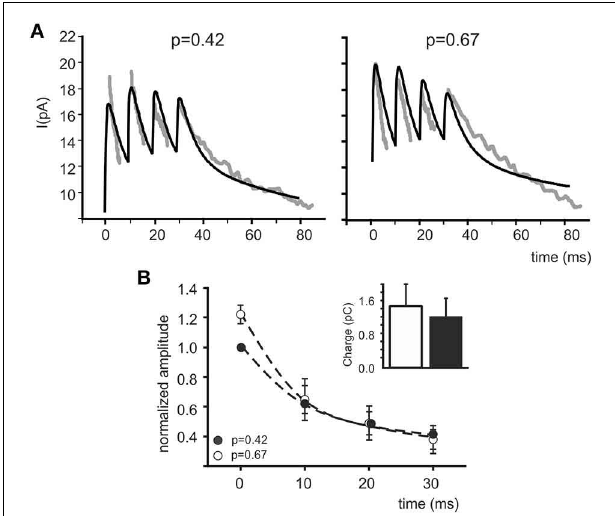
FIGURE 3 | Fitting eIPSC trains with the model. (A) Fittings of experimental traces in control and after CGP55845 perfusion (taken from Mapelli et al., 2009). Both traces are fitted simultaneously with the model maintaining the same α 1 and α 6 receptor density and kinetic schemes, the same diffusion parameters and the same presynaptic ( τ R , τ F ) parameters. Only pI is left free to vary independently in the two traces. The fittings properly follow the experimental traces by adapting pI as the only independent parameter. (B) The plot shows normalized peak amplitude (mean ± MSE) obtained from fittings ( n = 5) of eIPSC trains ( n = 5). Similar to real data measurements (see Mapelli et al., 2009), the time course of changes after increasing pI demonstrates the increase in the first eIPSC and the tendency to attain control amplitude in subsequent responses (mean ± MSE). The histogram represents charge transfer during the simulated eIPSC trains, showing no significant difference between control and after increasing pI ( white bar and black bar ; p = 0 . 55 paired t